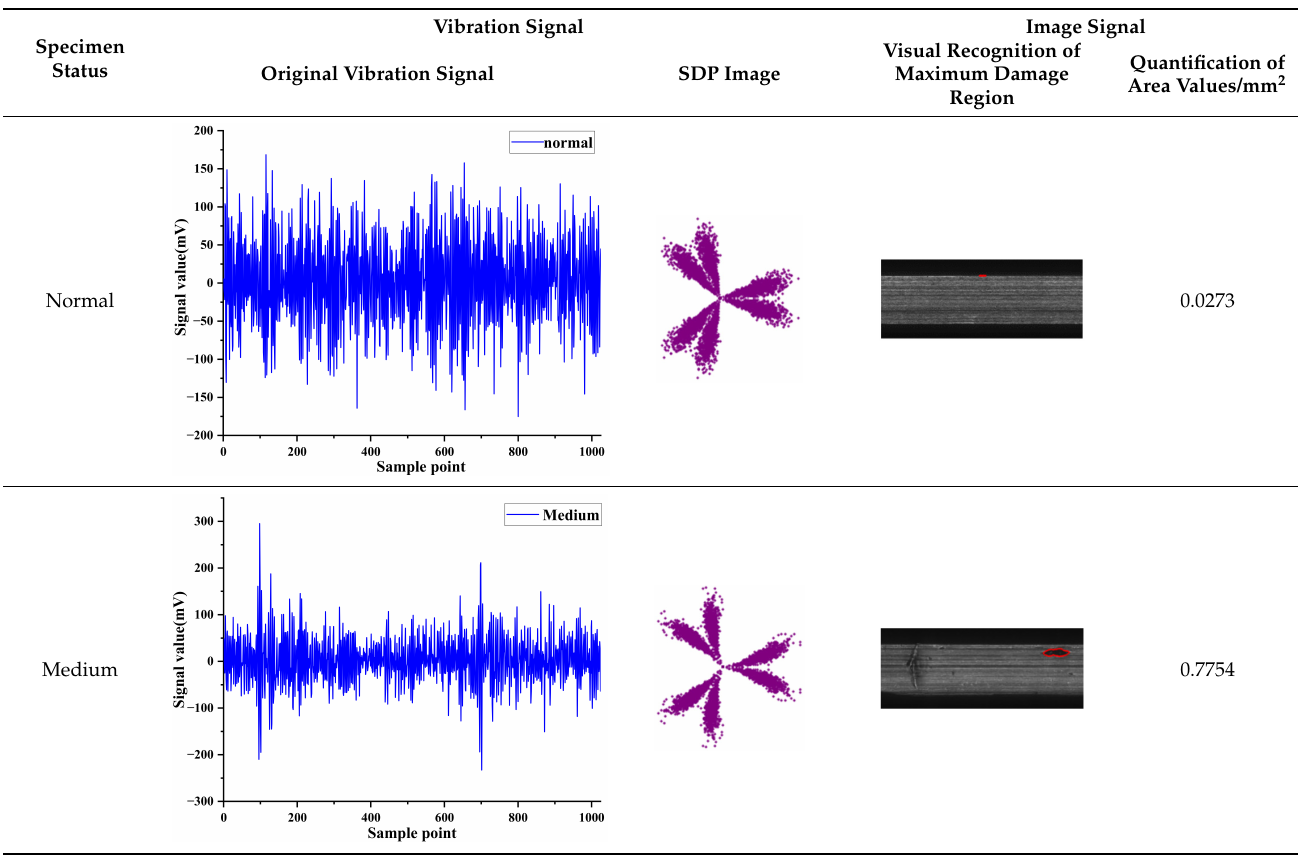
Table 10. A group of vibration and image signals of the specimen in three